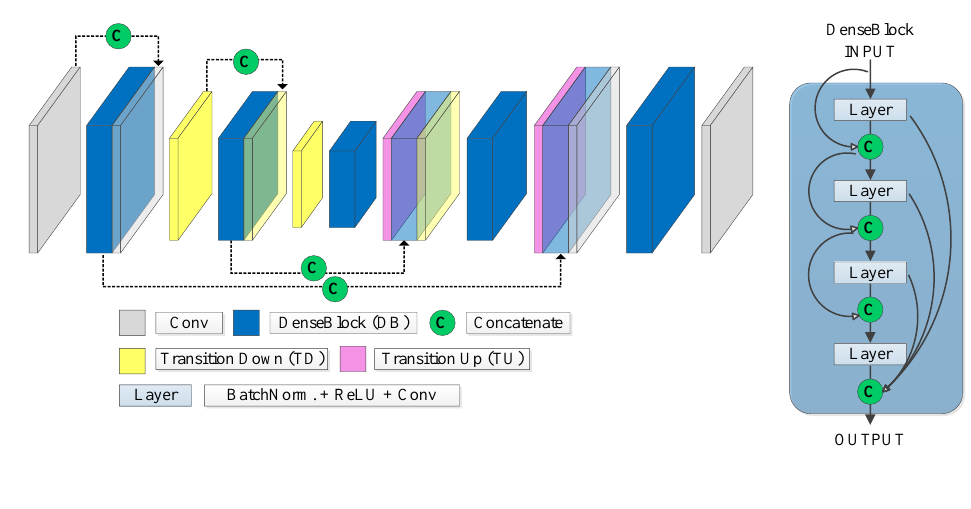
Figure 5. FC-DenseNet